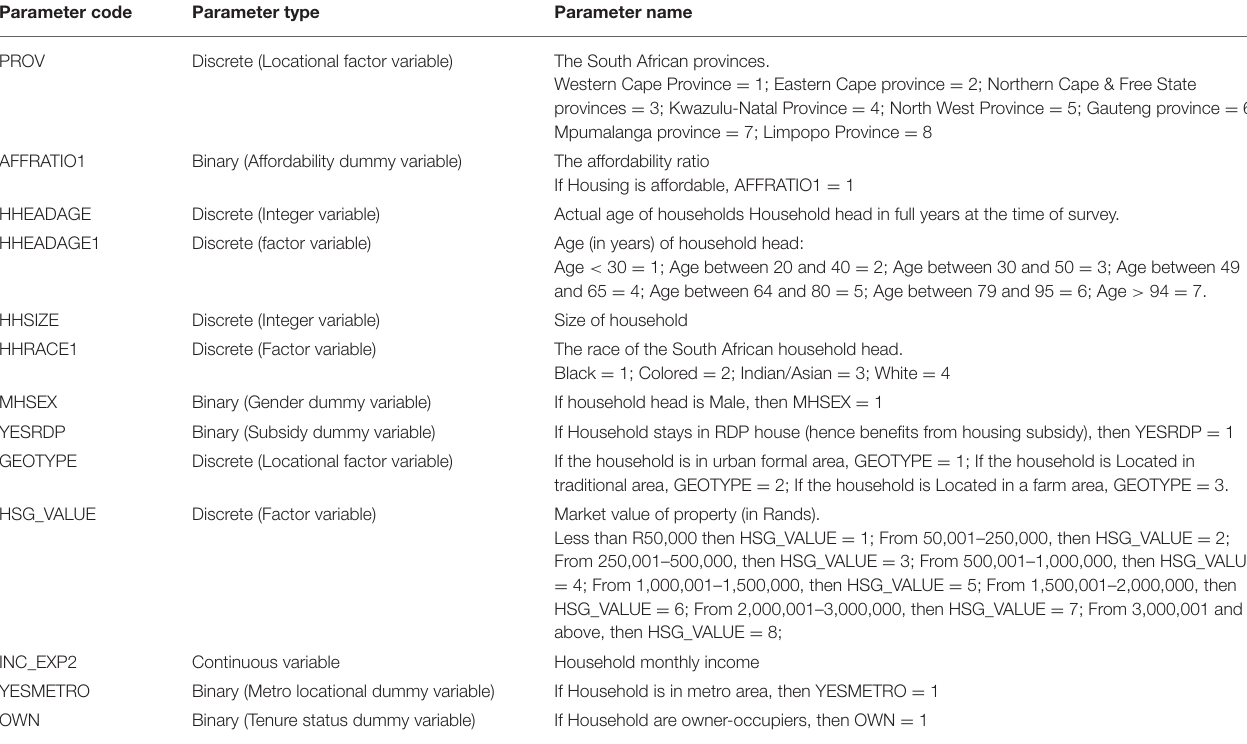
TABLE 1 | Variable